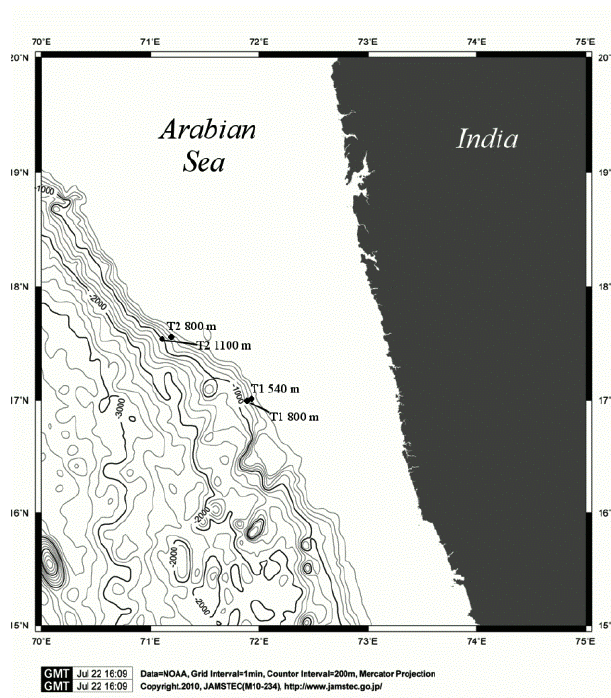
Fig. 1. Map of the study area indicating the location of experimental